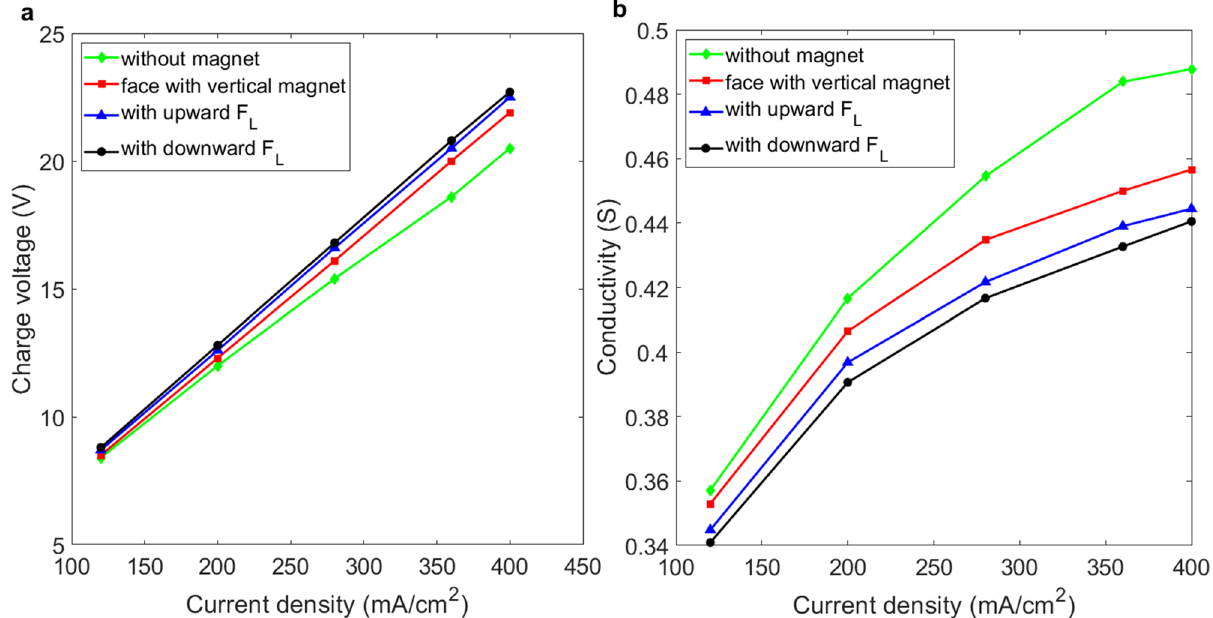
Figure 8. Comparison of the conductivity for vertical platinum electrodes in various configurations of magnetic field which constitute a duct with an upward exit. ( a ) Charging voltage vs. current density for the experimental layout in Fig. 1d–f. ( b ) Conductivity vs. current density for the experimental layout in Fig.